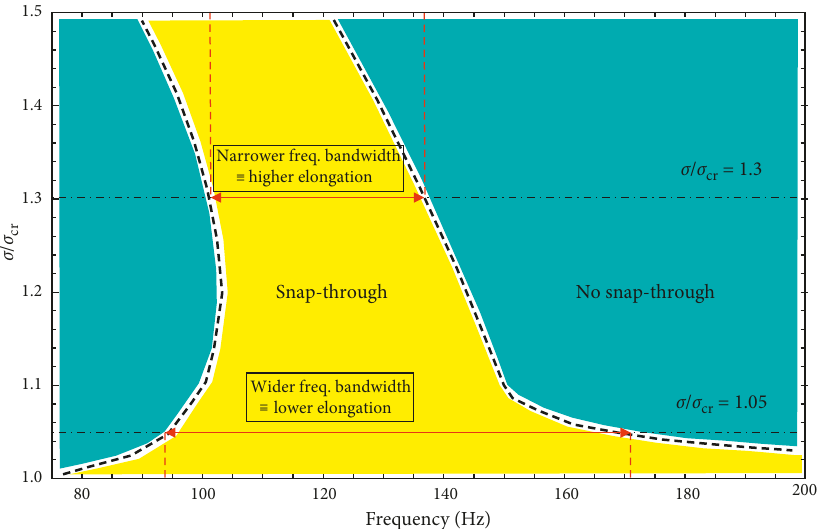
Figure 9: Snap-through regime plot of the MEMS device for buckling stress versus exciting